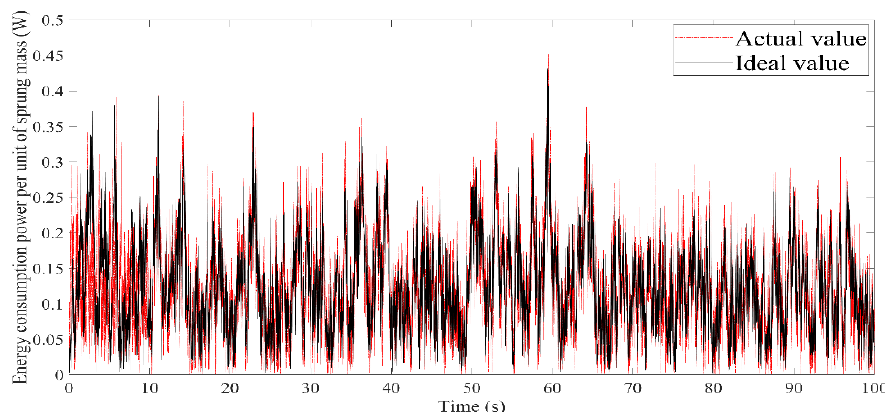
Figure 14. Energy consumption power per unit of sprung mass.